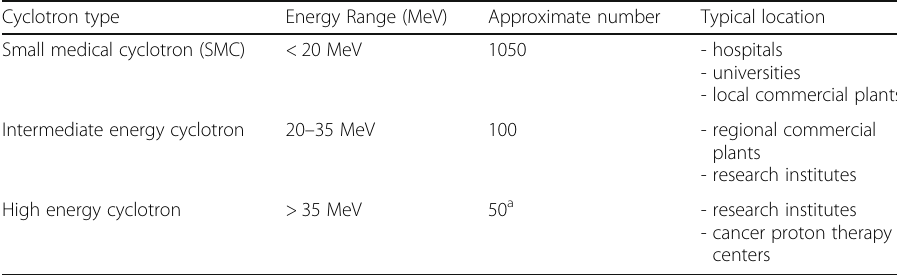
Table 2 Distinction of cyclotron types (Goethals and Zimmermann, 2015) Cyclotron type Energy Range (MeV) Approximate number Typical location Small medical cyclotron (SMC)